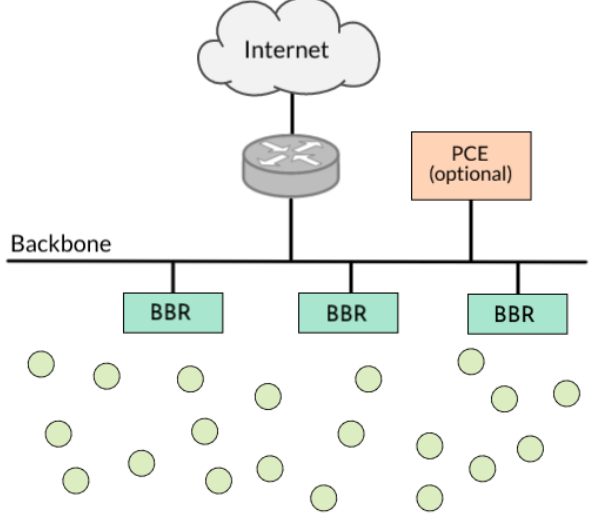
Figure 3. 6TiSCH network with several backbone routers (BBR) and an optional Path Computation Entity (PCE).